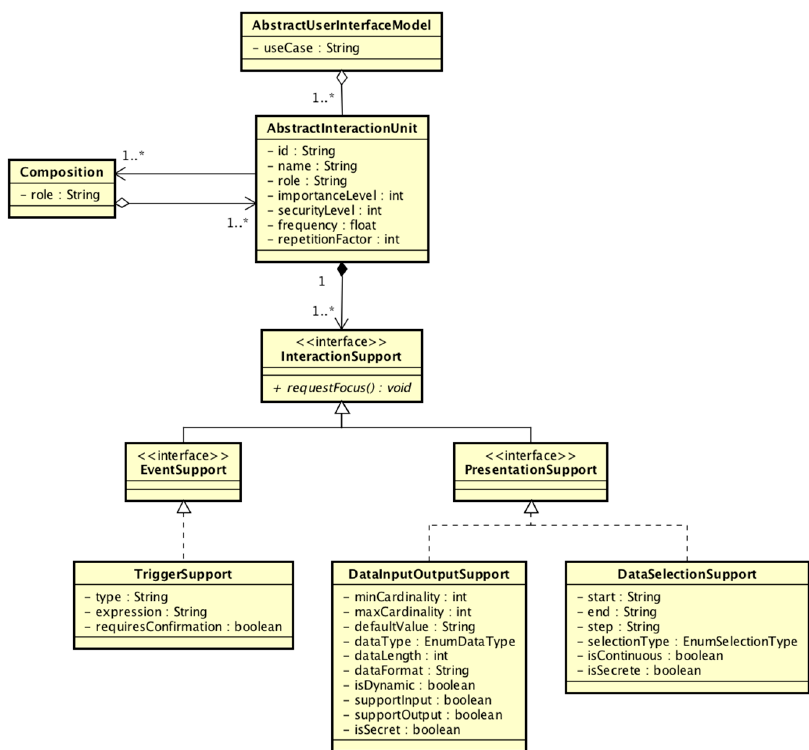
Figure 4. Class conceptual model of the Abstract Interaction Model directly inspired by the UsiXML Abstract User Interface